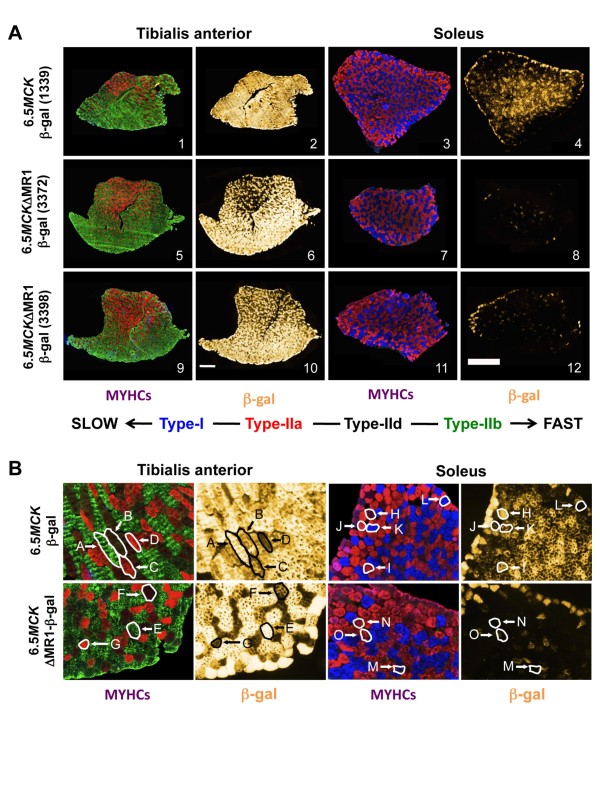
MR1 is important for MCK expression in slow- and intermediate-twitch skeletal muscle fibers. (A) Sister sections of tibialis anterior (TA) and soleus muscles from mice carrying the 6.5MCK-β-gal or the 6.5ΔMR1-β-gal transgenes, immunostained with myosin heavy chain (MYHC) fiber type-specific monoclonal antibodies (panels 1, 3, 5, 7, 9 and 11) or activity stained for β-galactosidase (β-gal) expression (panels 2, 4, 6, 8, 10 and 12). Antibodies for different isoforms and fluorophore-labeled secondary antibodies mark the fiber types as follows: slow-twitch fibers (type I), blue; intermediate-twitch fibers (type IIa), red; and fast-twitch fibers (types IIb and IId), green and black, respectively (the black appearance of type IId fibers is due to the absence of any type 1, IIa, or IIb antibody binding). Purplish fibers contain both types I and IIa MYHCs (see Figure 5B, soleus), and fibers with weak red or green staining probably contain mixtures of type IId (no color) + type IIa or type IId + type IIb, respectively (see Figure 5B, TA). Sister sections were stained for β-gal expression (false colored gold). Bars are 0.5 mm. (B) Higher magnification sections indicate differences in β-gal expression between fiber types in transgenic lines with and without MR1. Individual fibers, outlined in white or black to show relative differences in X-gal staining between fiber types (type I = K, L and O; type IIa = C, D, G, I and J; type IId = B, F, H and M; and type IIb = A and E), can be cross-referenced to β-gal expression in sister sections.